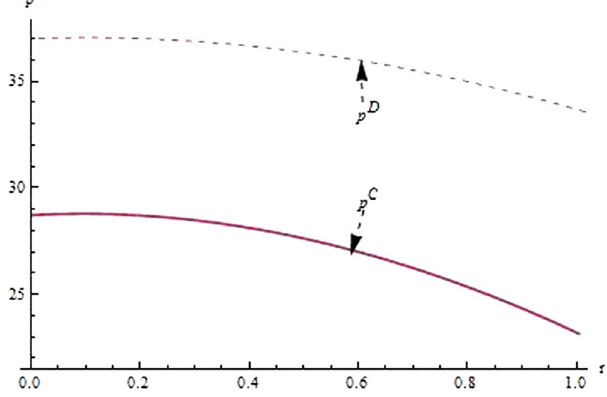
Figure 4. The impact of customers’ environmental awareness on the product